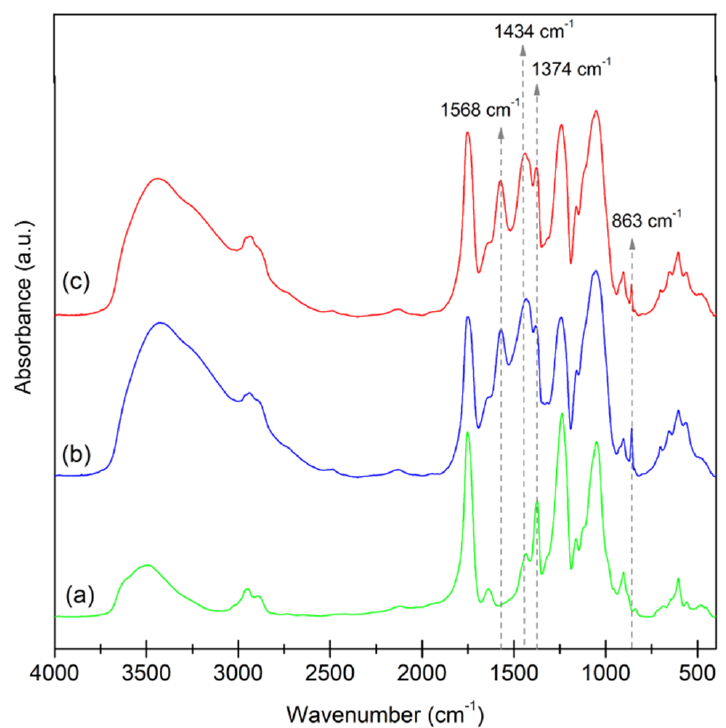
Figure 3. Vibrational spectra in the infrared region of the CA ( a ), CA7dSrP ( b ), and CA14dSrP ( c ).